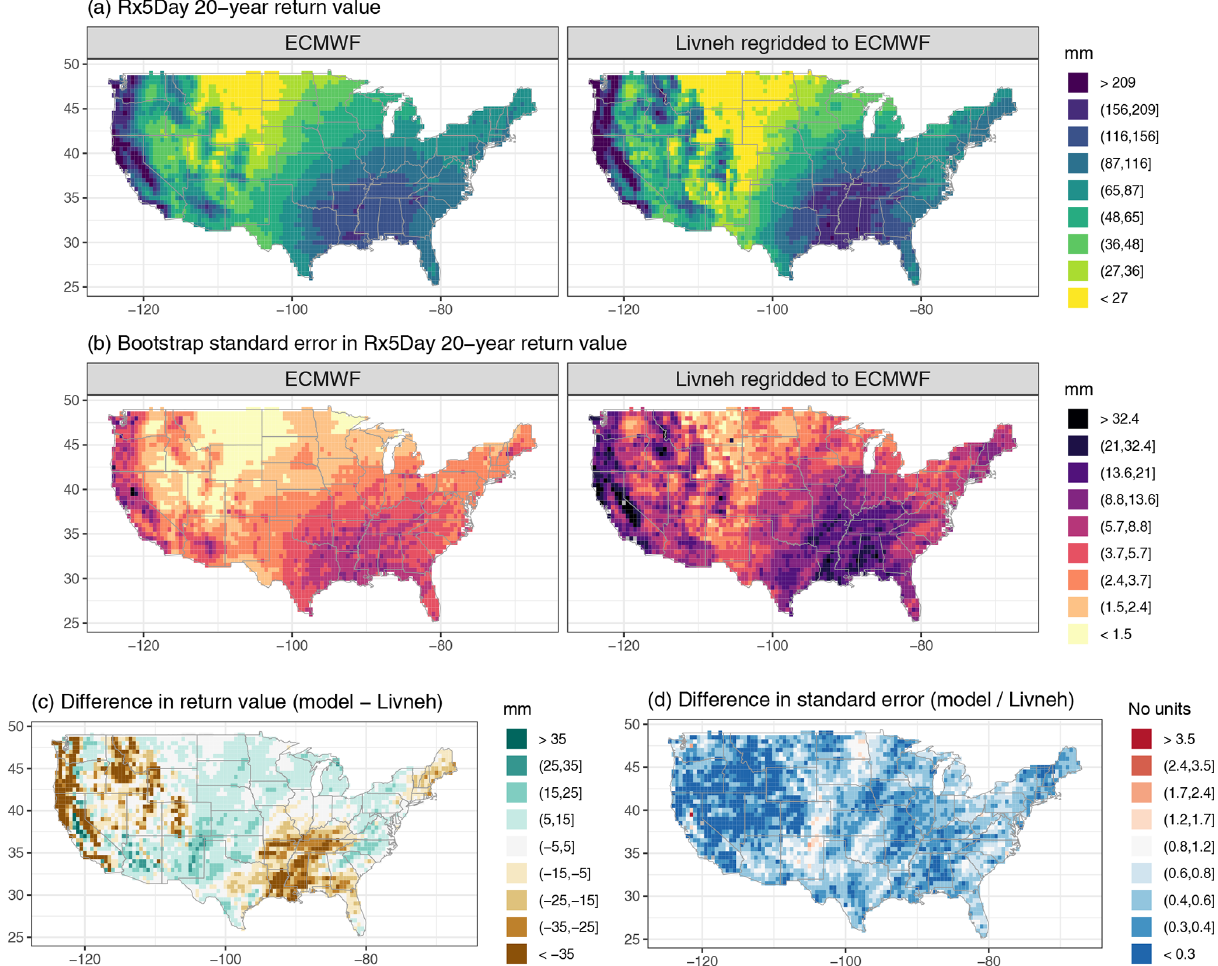
Figure A4. Wintertime (DJF) 20-year return values in Rx5Day (mm) for the ECMWF model and regridded L15 (a) , with the bootstrap standard error (mm; b ). Also shown is the difference in return values (model minus regridded L15) as well as the ratio of standard errors (model divided by regridded